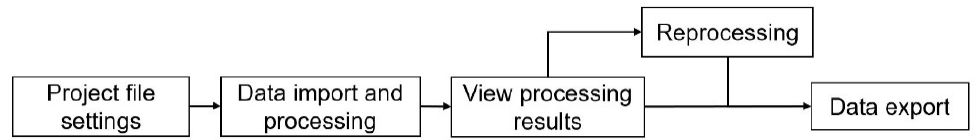
( b ) ( c ) Figure 8. Cloud map of artificial forest points in three paths. (( a ) shows straight-line path; ( b ) shows S-line path; ( c ) shows loop path). ( a ) ( b ) ( c ) Figure 9. Laser odometer diagram of three paths. (( a ) shows straight-line path error; ( b ) shows S- type line path error; ( c ) shows loop path). 2.2.4. Livox Mid-40 Data Acquisition For the acquisition of 3D point clouds of large-scale plantations, the loop path plan- ning alone cannot cover the whole area fully, with missing point clouds inside the plan- tation. Therefore, when planning the path of large-scale plantations, a combination of